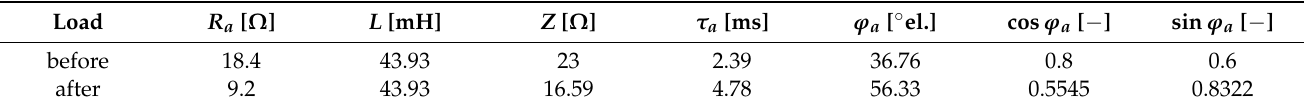
Table 37: Table 37. Load parameters for steady states before and after load change.